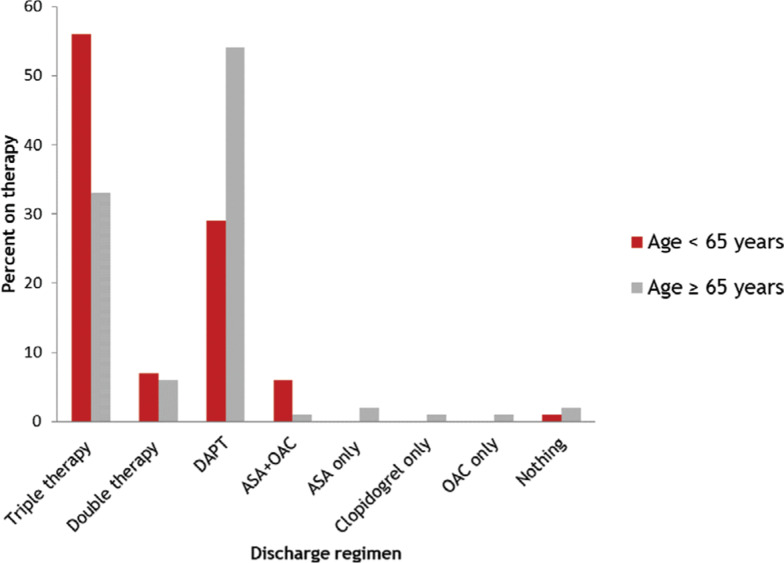
Antithrombotic regimen in patients with AF undergoing PCI (n = 211). Overall, 46.0% of patients were discharged with DAPT, while 40.3% were discharged with triple therapy. When stratified by age, there were significantly more patients younger than 65 years of age who were prescribed triple therapy or any regimen that included OAC as compared with patients older than 65 years of age. Expectedly, the reverse was true for DAPT: patients who were older than 65 years of age were prescribed significantly more DAPT than those who were younger than 65 years of age. ASA: aspirin; DAPT: dual antiplatelet therapy; OAC: oral anticoagulation.